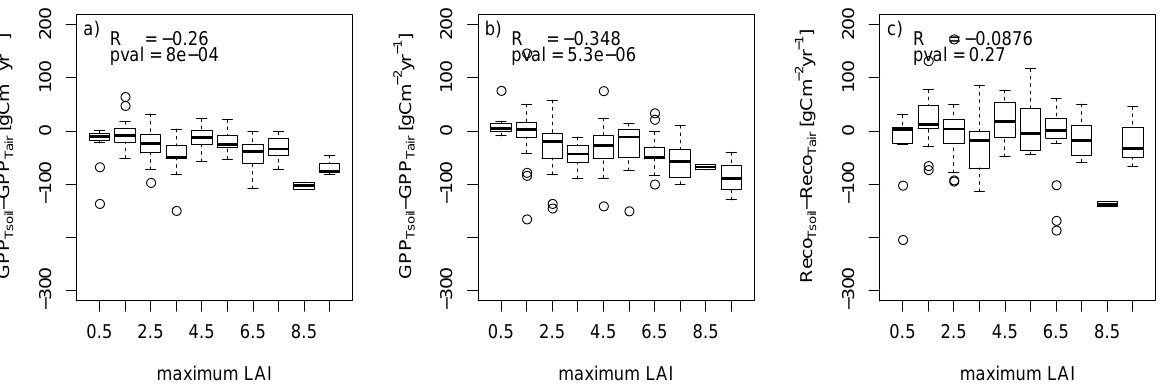
Fig. 11. Difference in annual GPP estimates using the Reichstein et al. (2005) approach (a) (note that for the R eco estimates the plot would be exactly the same) and in annual GPP (b) and R eco (c) estimates using the Lasslop et al. (2010) approach versus the maximum LAI measured at the site.